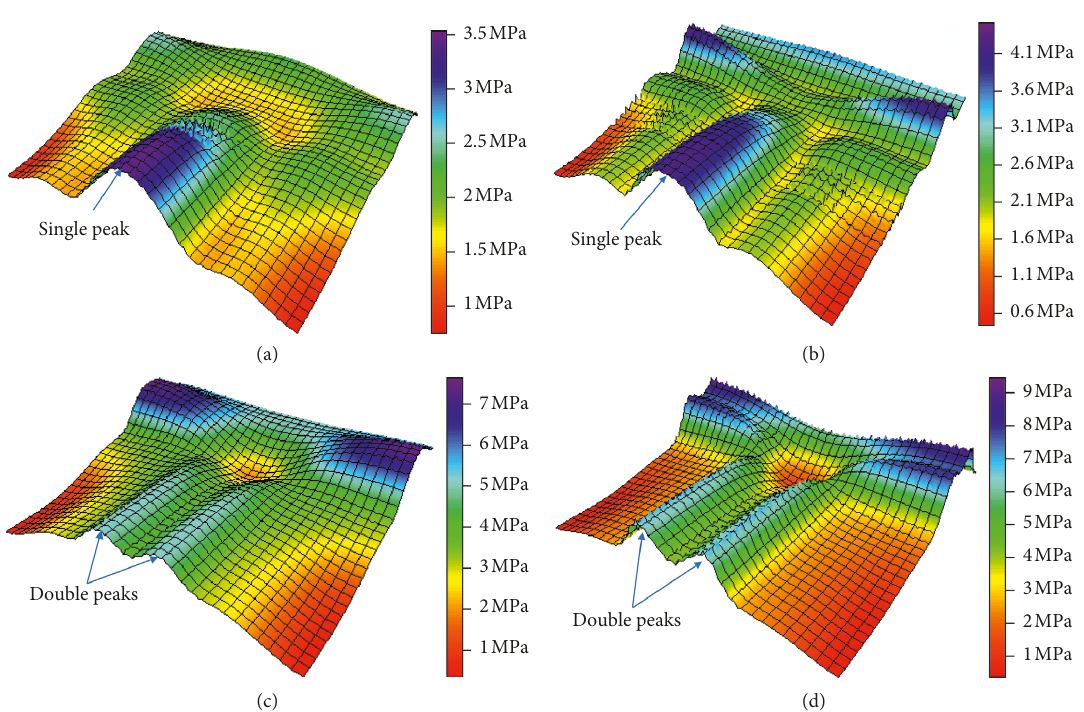
Figure 7: Distribution of principal stress difference under the upper coal floor. (a) #16 coal seam floor. (b) #16 coal seam roof. (c) 7m above #16 coal seam. (d) 14m above #16 coal